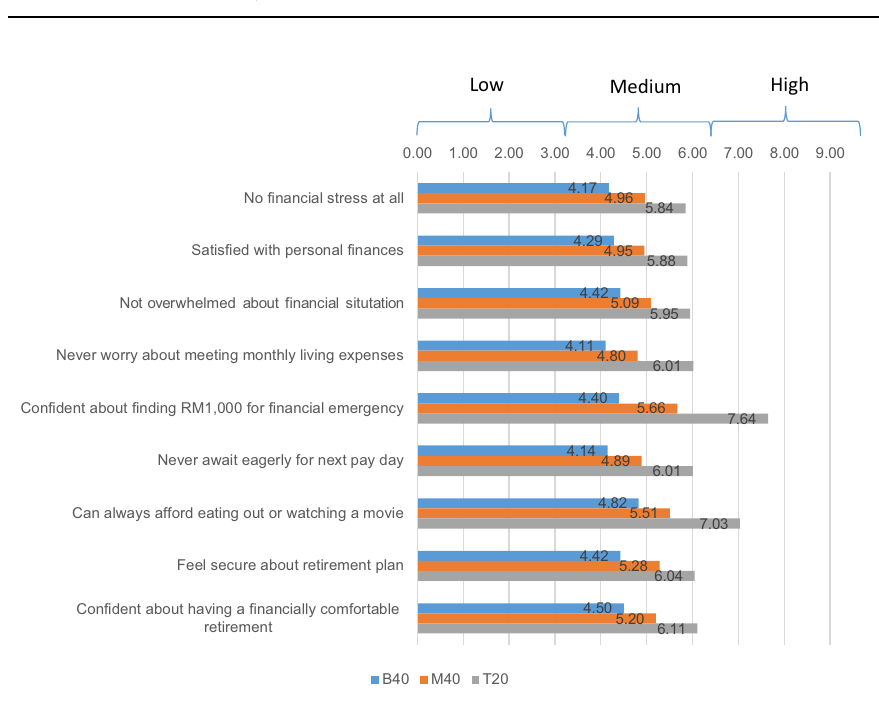
Table 8. One-way ANOVA